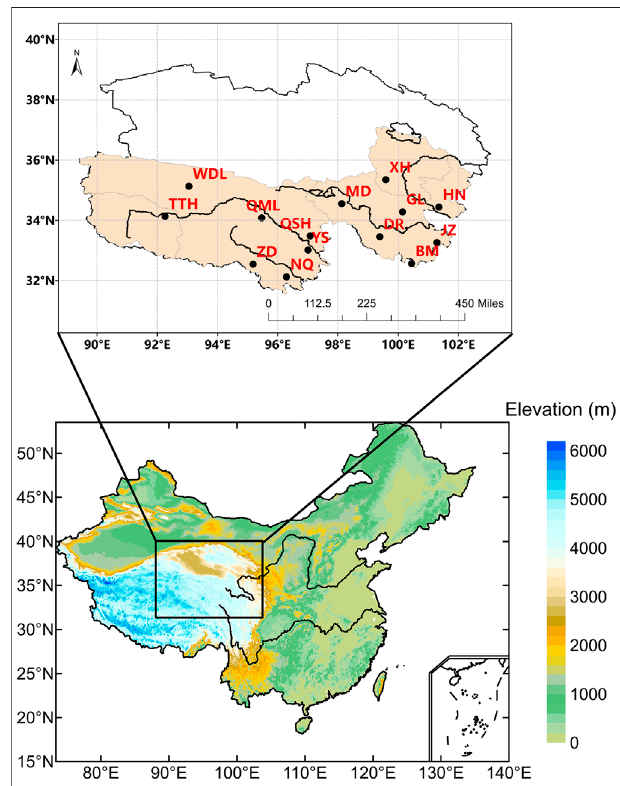
FIGURE 1 | Scope of the source regions of Three-River Headwaters (TRH) and location of weather stations (unit: m).